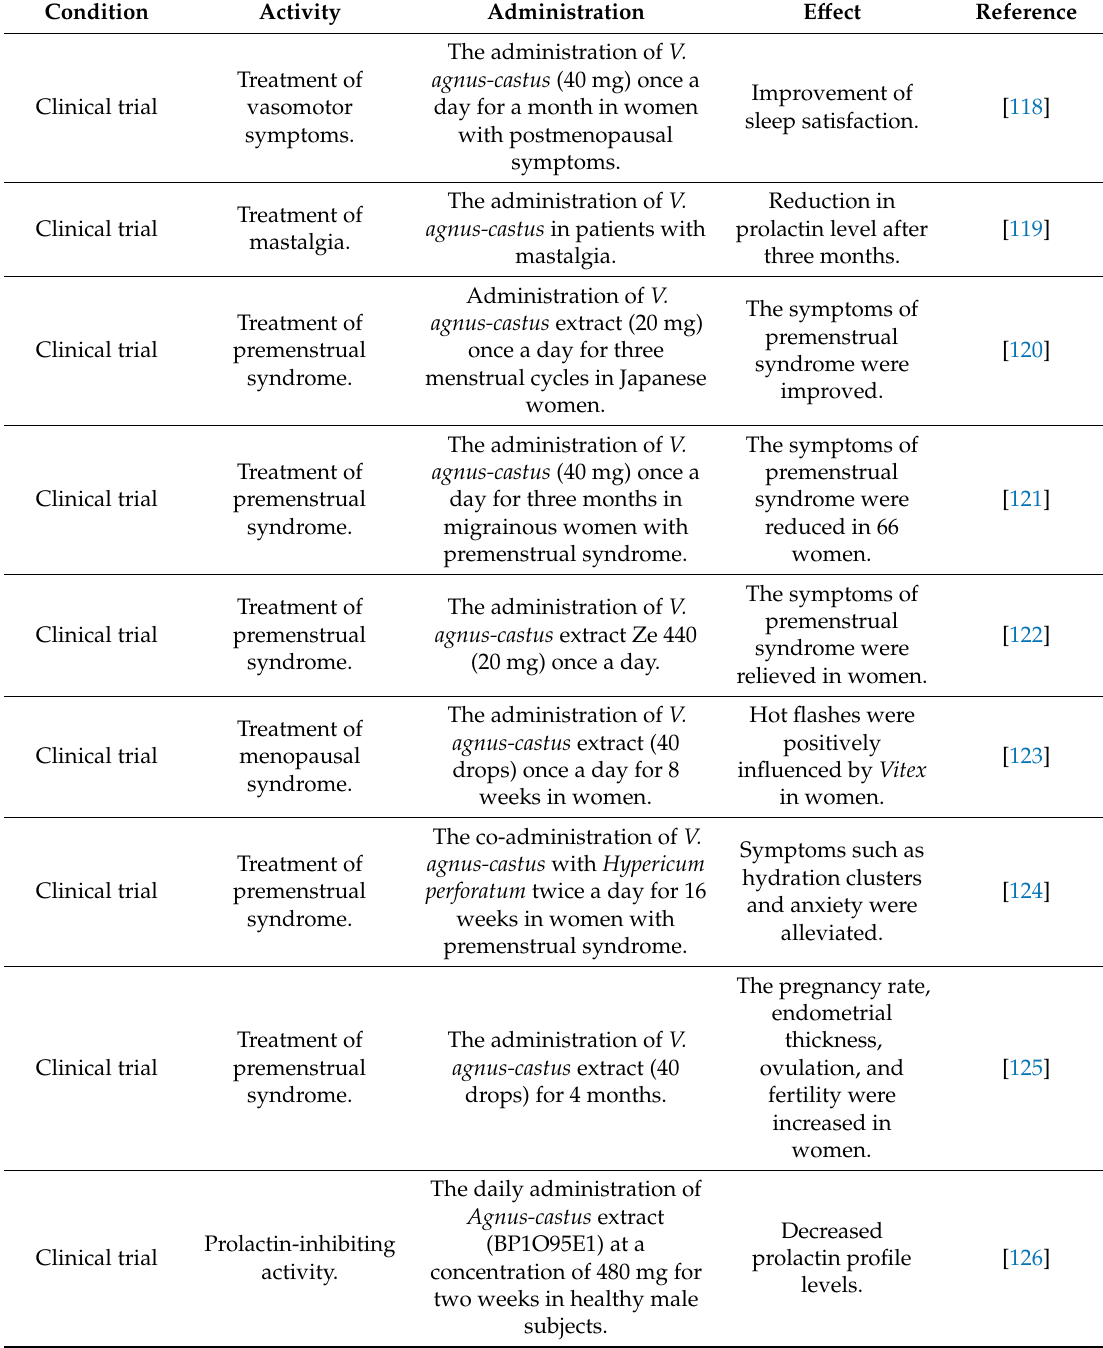
Table 3. Clinical trials reporting V. agnus-castus L.